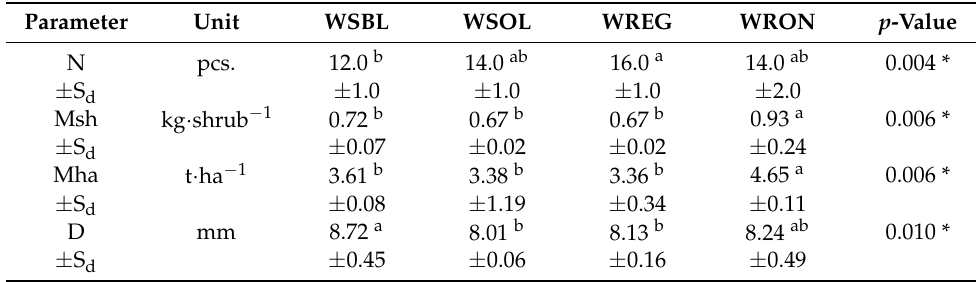
Table 2. Evaluation of lignified shoots of grapevines of Seyval Blanc-WSBL, Solaris-WSOL, Regent- WREG and Rondo-WRON varieties constituting potential dry